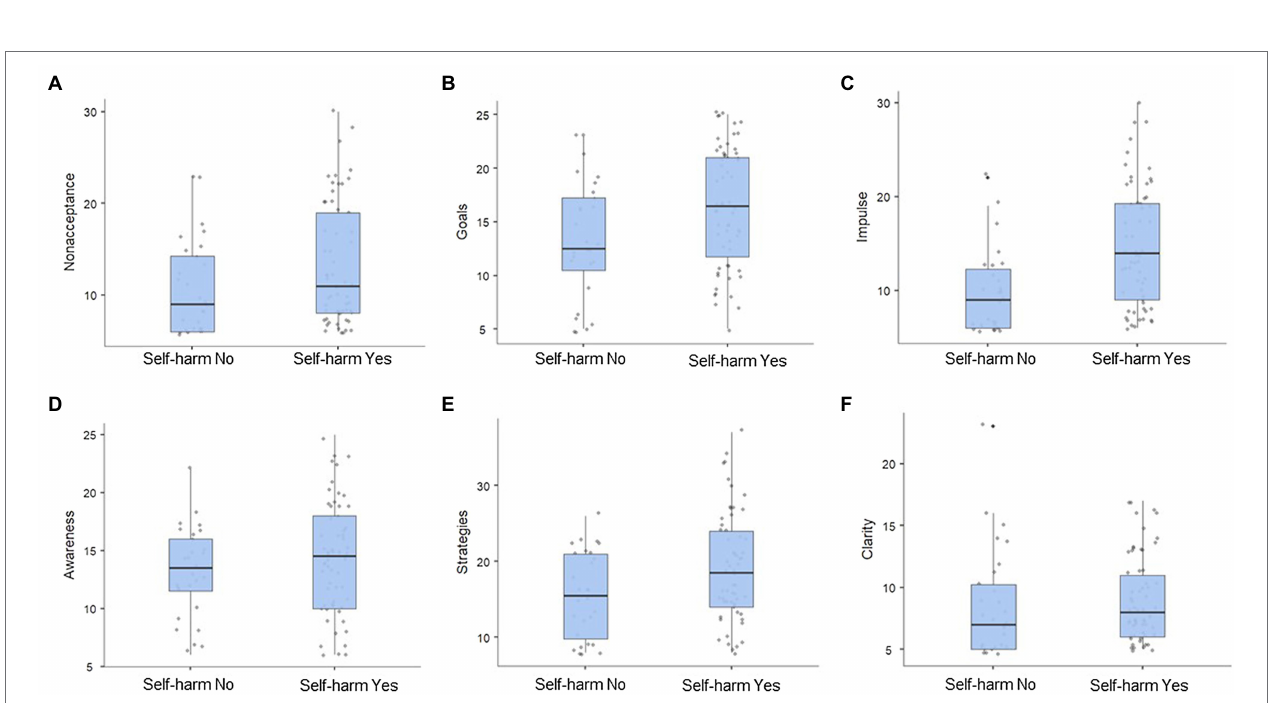
FIGURE 1 | Distribution of DERS subscale scores in forensic psychiatric patients ( n = 88). * (A) = Non-acceptance; (B) = Goals; (C) = Impulse; (D) = Awareness; (E) = Strategies; and (F) = Clarity.